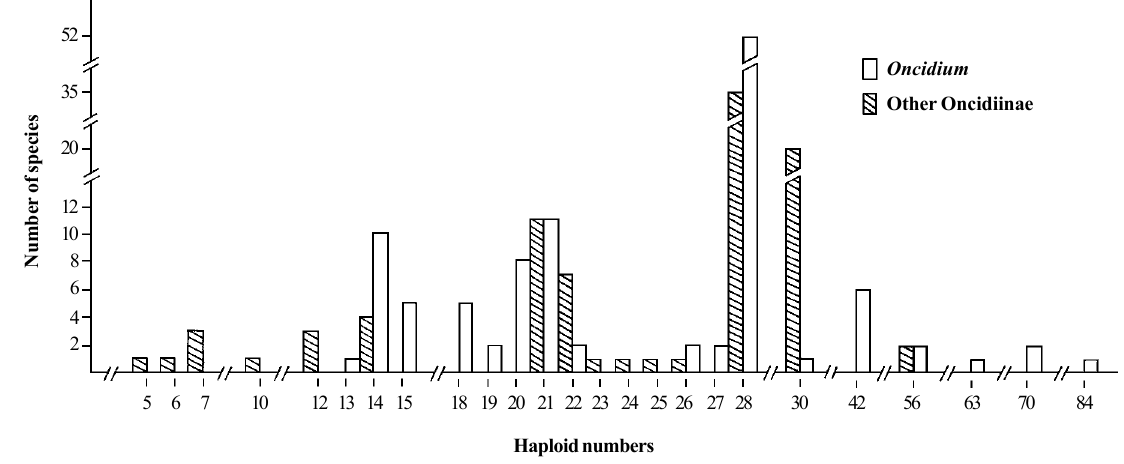
Figure 6 - Chromosome number variation among Oncidium species compared to other